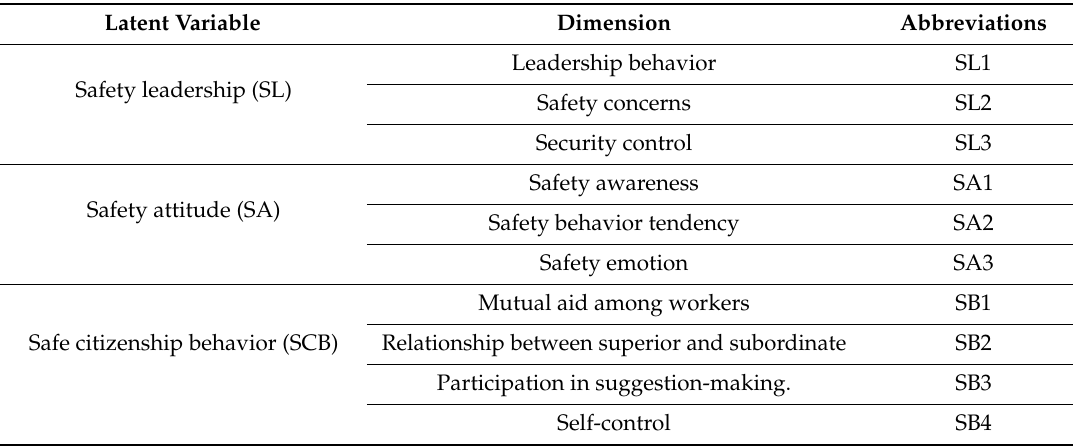
Table 1. Dimension division and abbreviations of safety leadership, safety attitude and safety citizenship